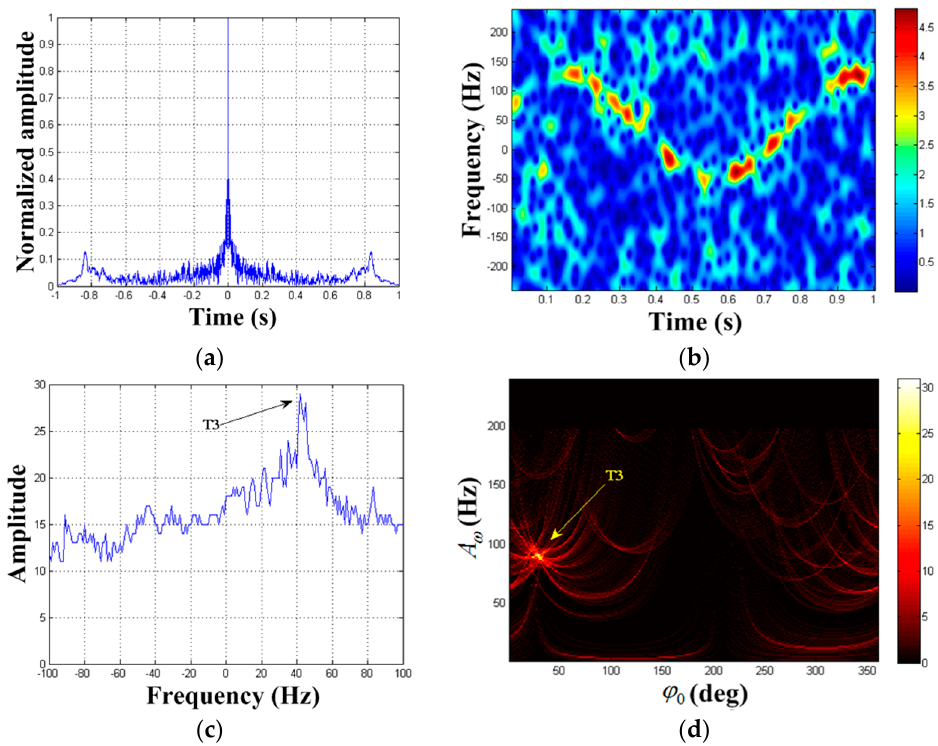
Figure 7. Detection result of x 2 ( t a ) . ( a ) Autocorrelation result of x 2 ( t a ) ; ( b ) TF distribution result of